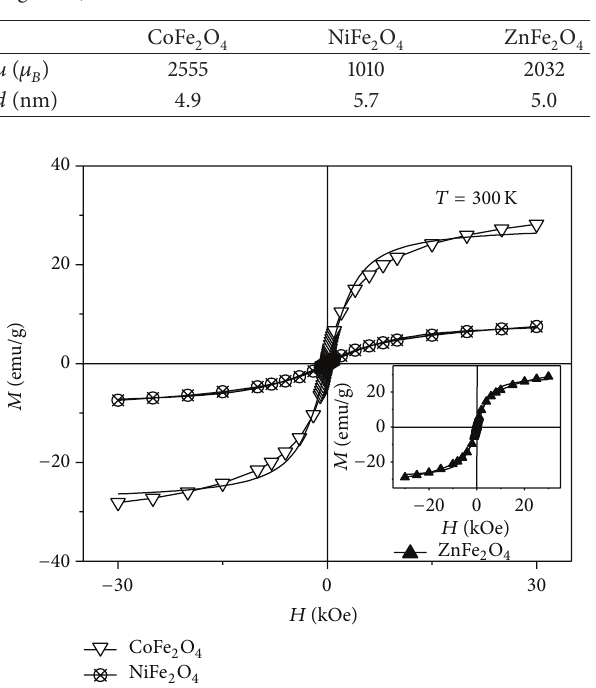
Table 2: The average magnetic moment 𝜇 and upper limit of particle diameter 𝑑 calculated from the fitted M ( H ) curves ( 𝜇 𝐵 is the Bohr magneton).